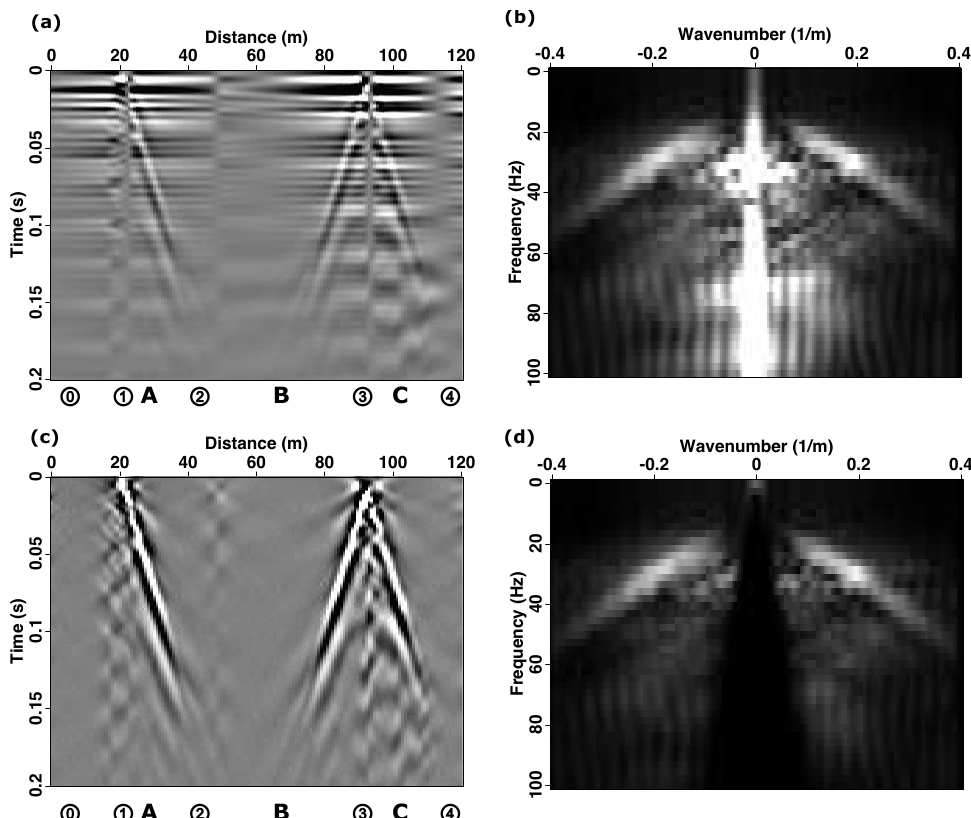
Figure 3. ( a ) Velocity data for a hammer shot recorded at 9:00 pm after applying the polarity correction to Section B. Note that the record is contaminated with horizontal noise that has a moveout too fast to be a seismic event. ( b ) The associated frequency–wavenumber f − k plot where the vertical “washboard” striping is due to the presence of the horizontal unwanted but repeated signals observed in ( a ). ( c ) 2D dip-filtered velocity data for the same shot in ( a ) that now shows refracted-wave arrivals. ( d ) The f − k spectra for the filtered shot record shown in ( c